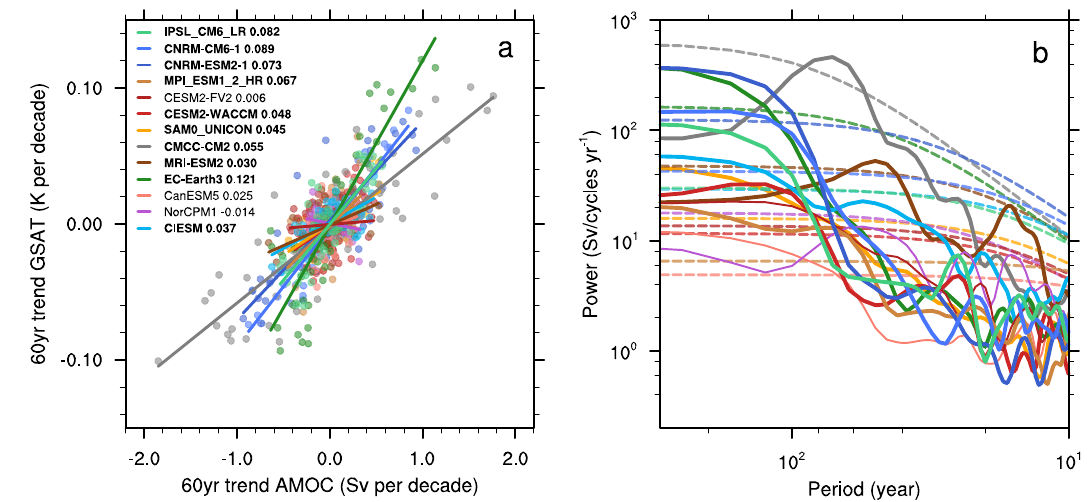
Fig. 4 Relationship between GSAT and AMOC in CMIP6 control simulations. a Scatter plot of Atlantic Meridional Overturning Circulation (AMOC) (Sv decade − 1 ) versus Global near-Surface Air Temperature (GSAT) (K decade − 1 ) trends calculated overall 60 year windows increasing by 10 years from the fi rst 500 years of the pre-industrial control (piControl) simulations of thirteen CMIP6 models. The lines represent the least square regression between these two variables for each model. The regression coef fi cients (K Sv − 1 ) are indicated in bold beside the model ’ s name when the regression is signi fi cant ( p < 0.1, see Methods). b Smoothed power spectra of the AMOC time series from the fi rst 500 years of the piControl simulations of the same thirteen CMIP6 models (solid lines, thick when the regression is signi fi cant), with the 95% con fi dence limit estimated from a red noise (dashed lines). A Lanczos low-pass fi lter with a cutoff period of 5 years is